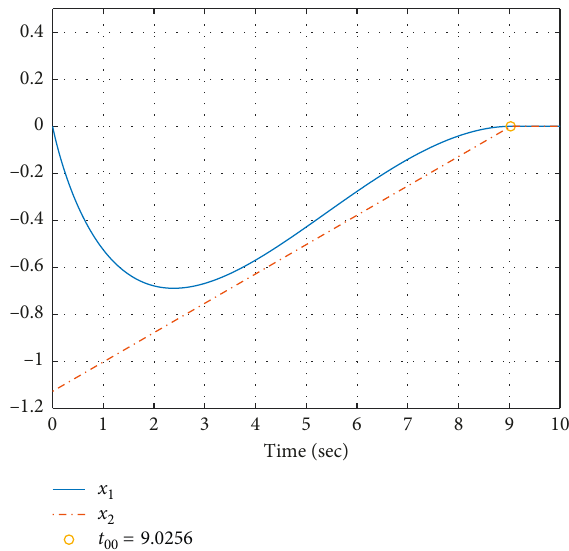
Figure 4: Finite-time convergence to the origin point with the nonzero initial condition of the state ( A � ( − 1/4)).